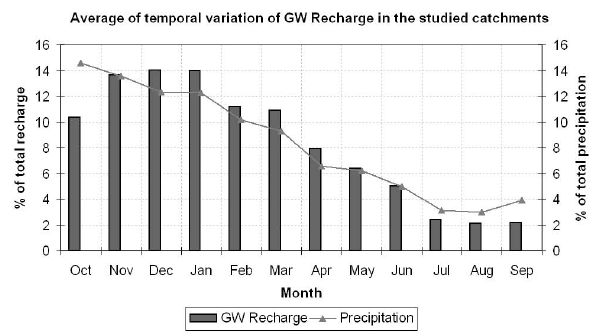
Fig. 6. Temporal variability of groundwater recharge: average per- centage of monthly groundwater recharge and precipitation along the year in the nine pilot